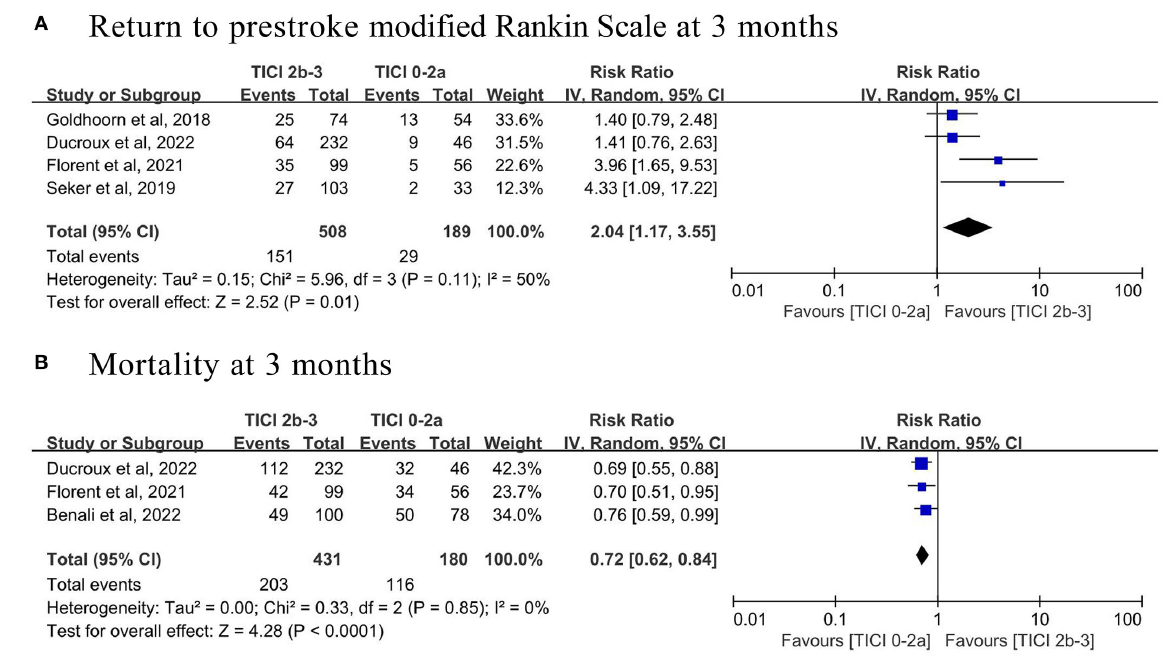
FIGURE4 Forest plot of (A) return to prestroke modified Rankin Scale and (B) mortality at 3 months in prestroke disability patients with vs. without successful recanalization (Thrombolysis In Cerebral Ischemia (TICI) 2b-3) after endovascular